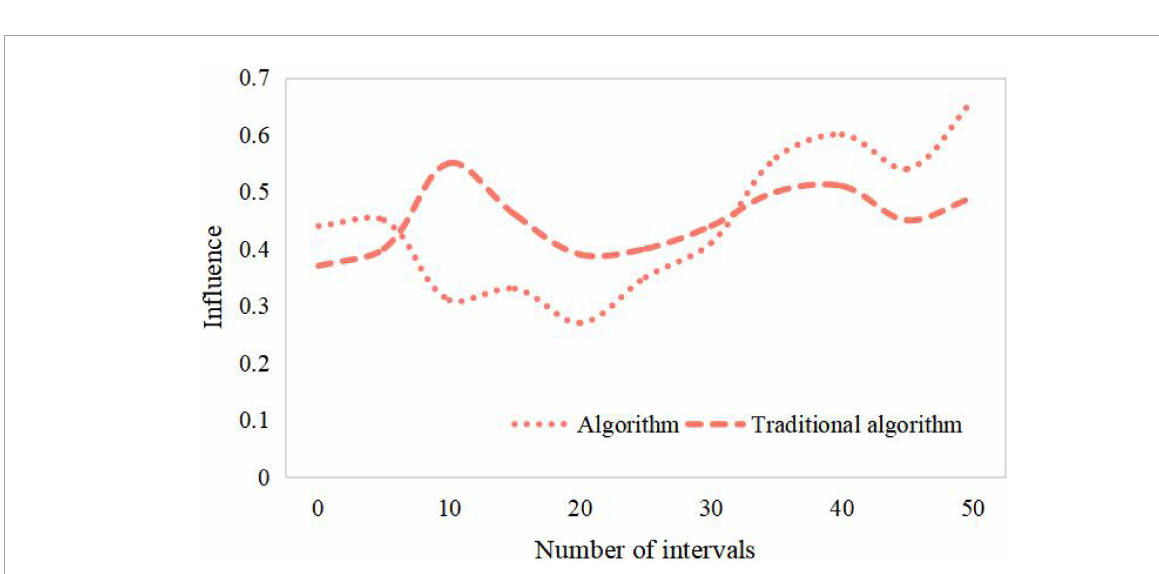
FIGURE7 Influence of different number of partition intervals on results.